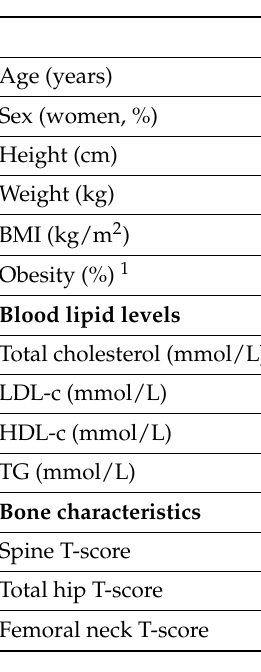
Table 2. Participants’ characteristics ( n =